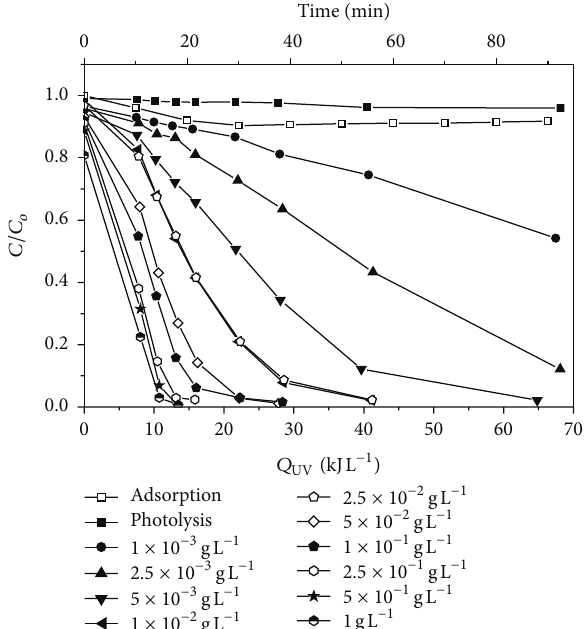
Figure 2: Effect of TiO 2 suspension concentration on the photocat- alytic degradation of 30 mgL −1 of